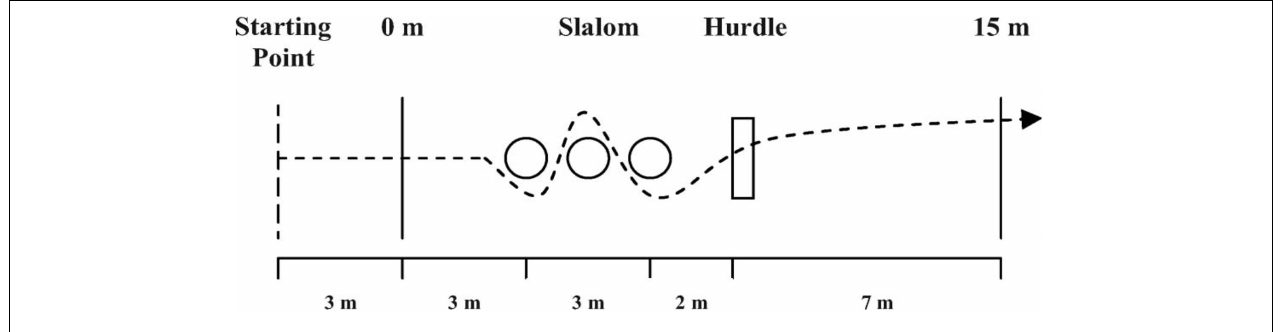
FIGURE 1 | Schematic representation of the CoD